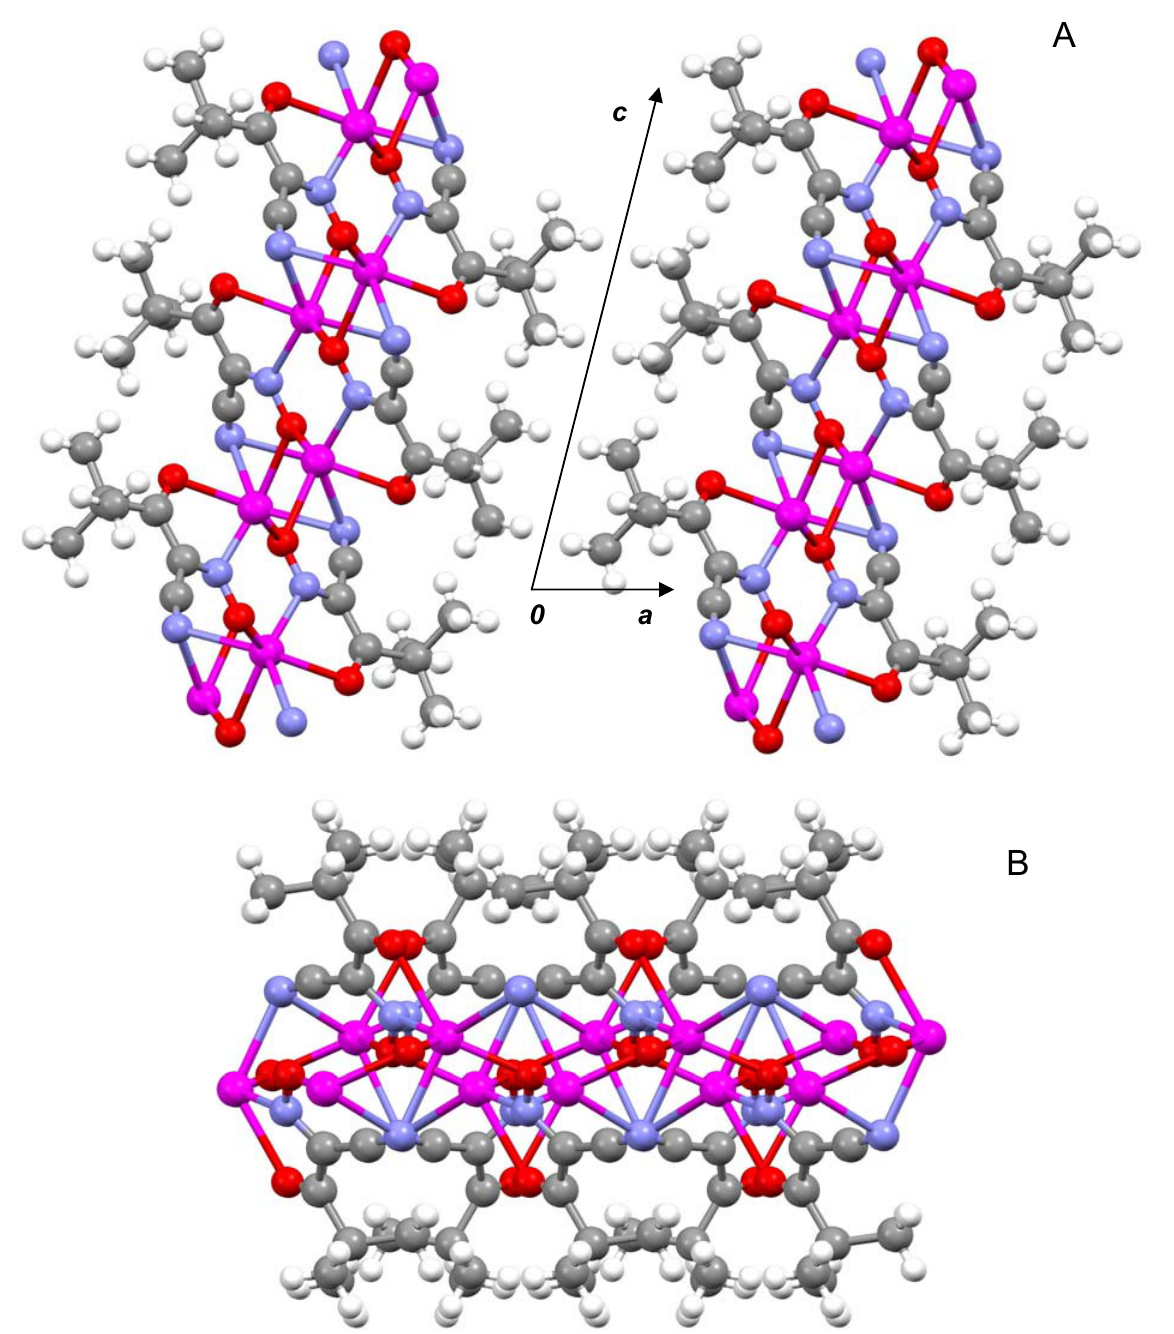
Figure 18. Organization of layered 2D structure of Ag(PiCO): view of two unit cells along a showing polymeric motif and inter-layer van-der-Waals interactions between t-butyl groups ( A ), and two views along c direction ( B